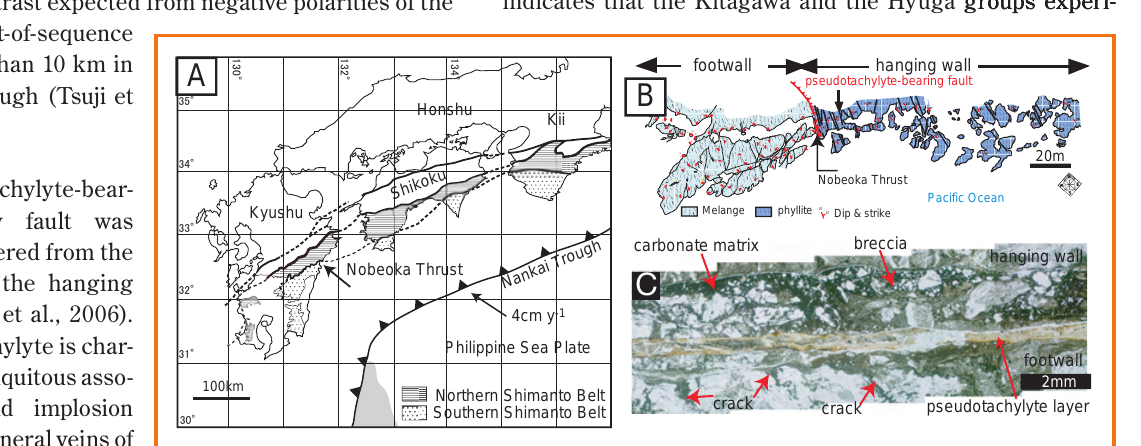
Figure 1. [A] Geological setting of the Nobeoka thrust and distribution of the Shimanto belt in southwest Japan. [B] Sketch map of horizontal exposure of the Nobeoka thrust and shear zone on the tidal flat (addition to Kondo et